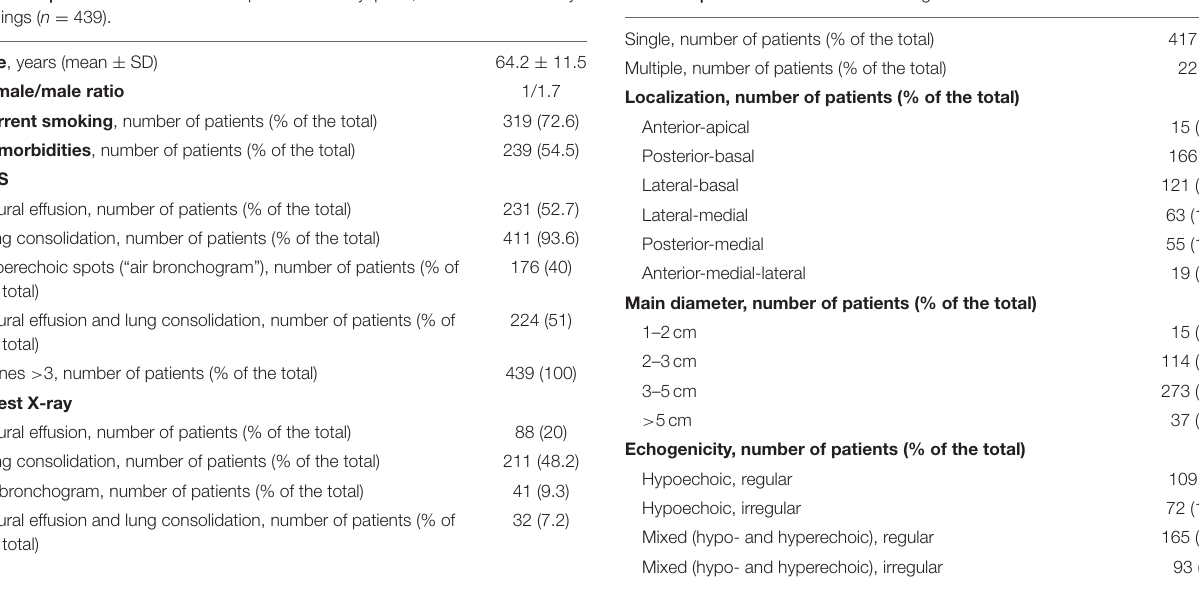
TABLE 2 | Ultrasound semeiotics of lung